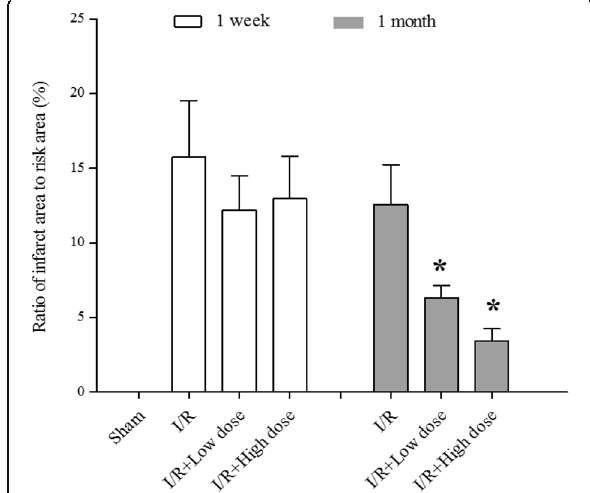
Fig. 1 Effects of MYQ on the infarct size caused by occlusion and reperfusion of the left anterior descending coronary artery in anesthetized rat hearts. MYQ was given after two-hours reperfusion (P.O. tid for 1 week or 1 month). The ratio of infarct size to area at risk was measured after one-week or one-month treatment with MYQ. Sham: Sham group ( n = 10); I/R: ischemic/reperfusion group ( n = 10). I/R + Low dose: Low dose (1 ml, P.O. tid for one-week or 1 month, n = 10 in each group) MYQ treatment group. I/R + High dose: High dose (4 ml, P.O. tid for one-week or 1 month, n = 9 in each group) MYQ treatment group. All data were expression as mean ± S.E.M. * P < 0.05 compared with I/R group